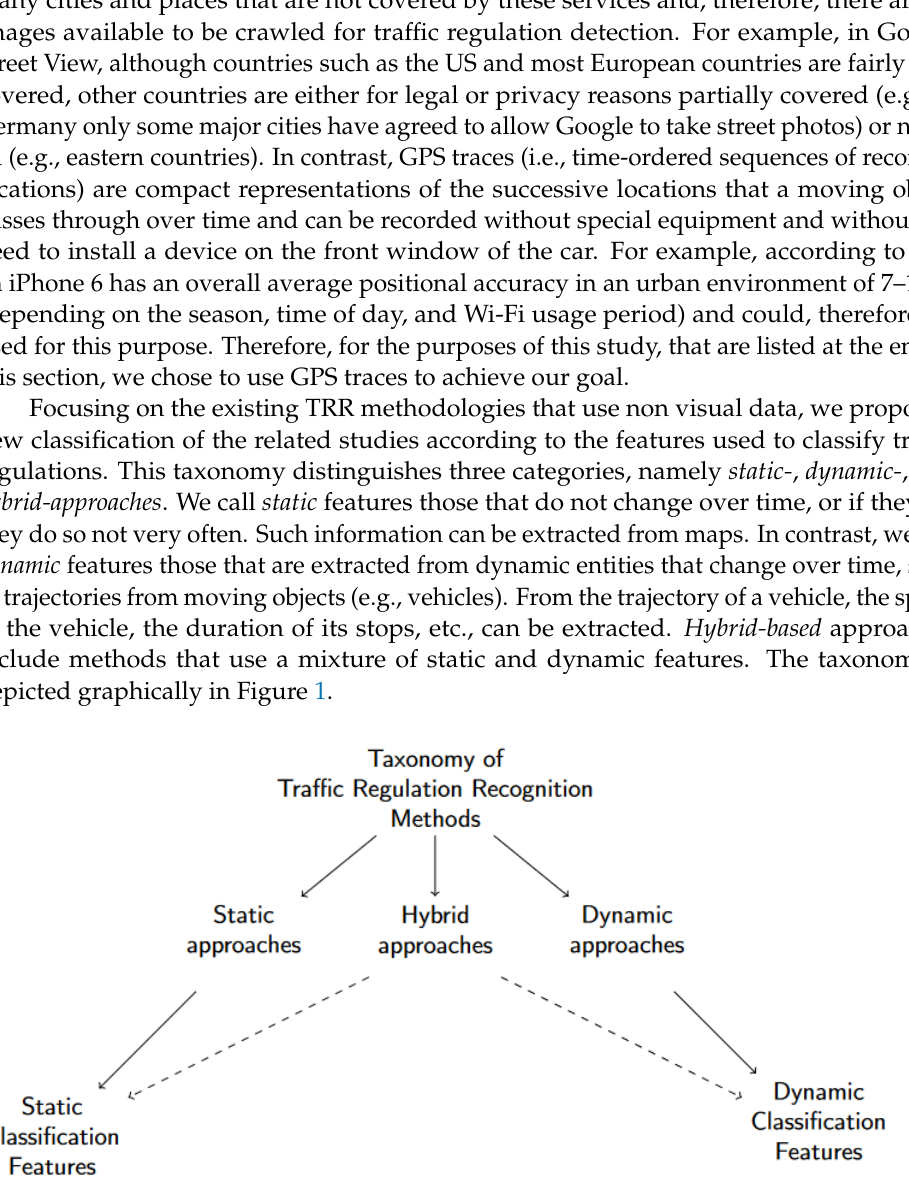
Figure 1. Taxonomy of methods for traffic regulation detection from crowdsourced GPS